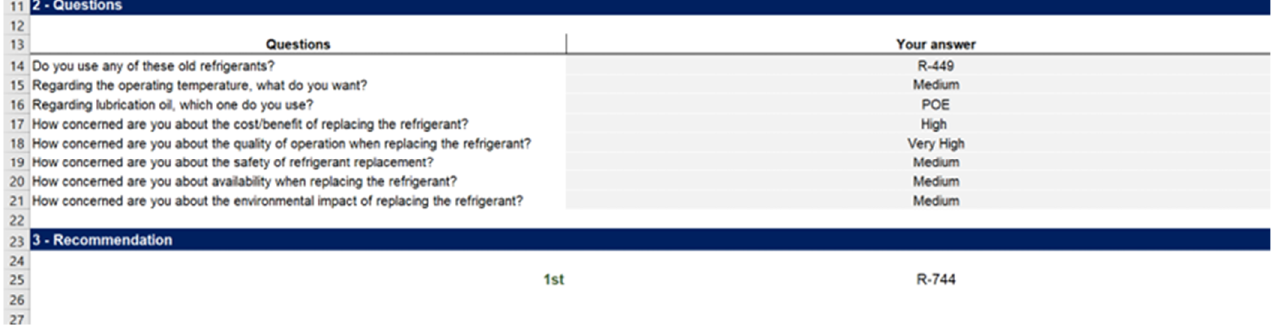
Figure 5. Solution for practical case one using low temperatures.